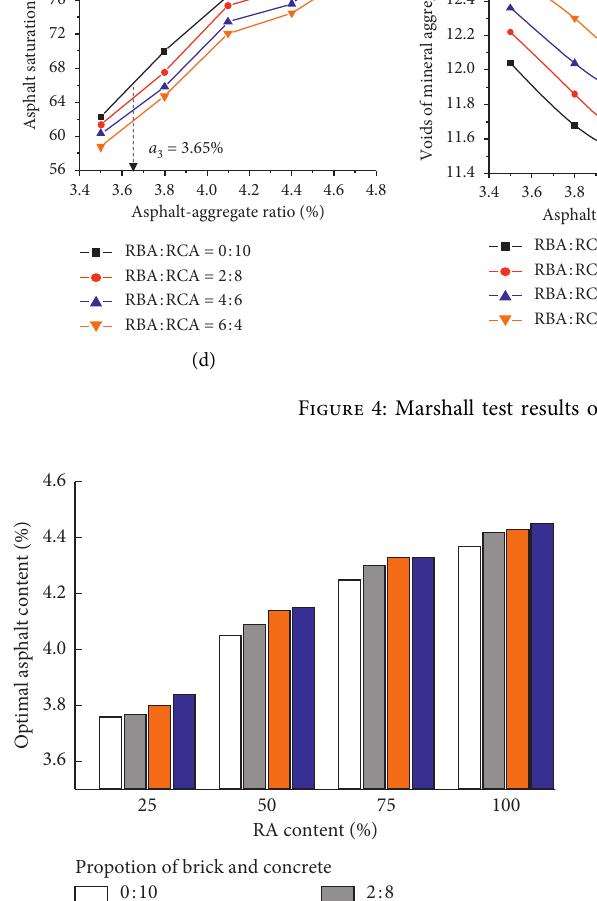
Figure 5: Optimum asphalt-aggregate ratio in different RCA